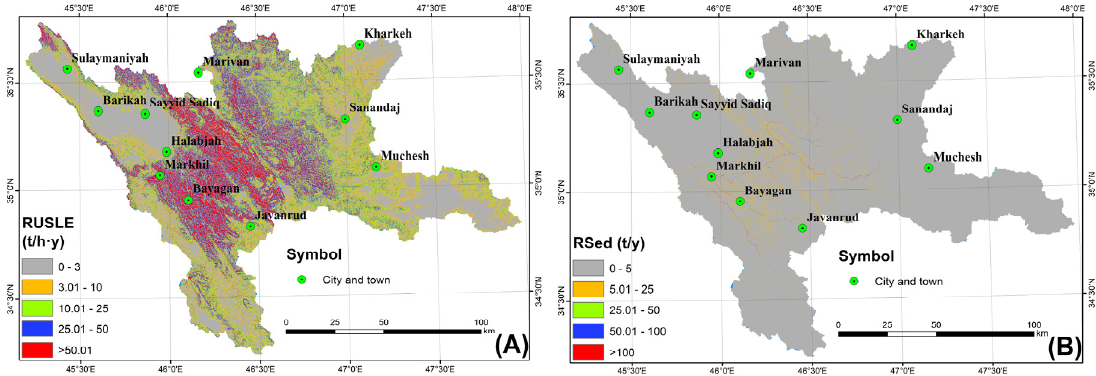
Figure 13. The average distribution of the ( A ) RUSLE maps and ( B ) reservoir sedimentation maps within the DLB for the period until 2019.